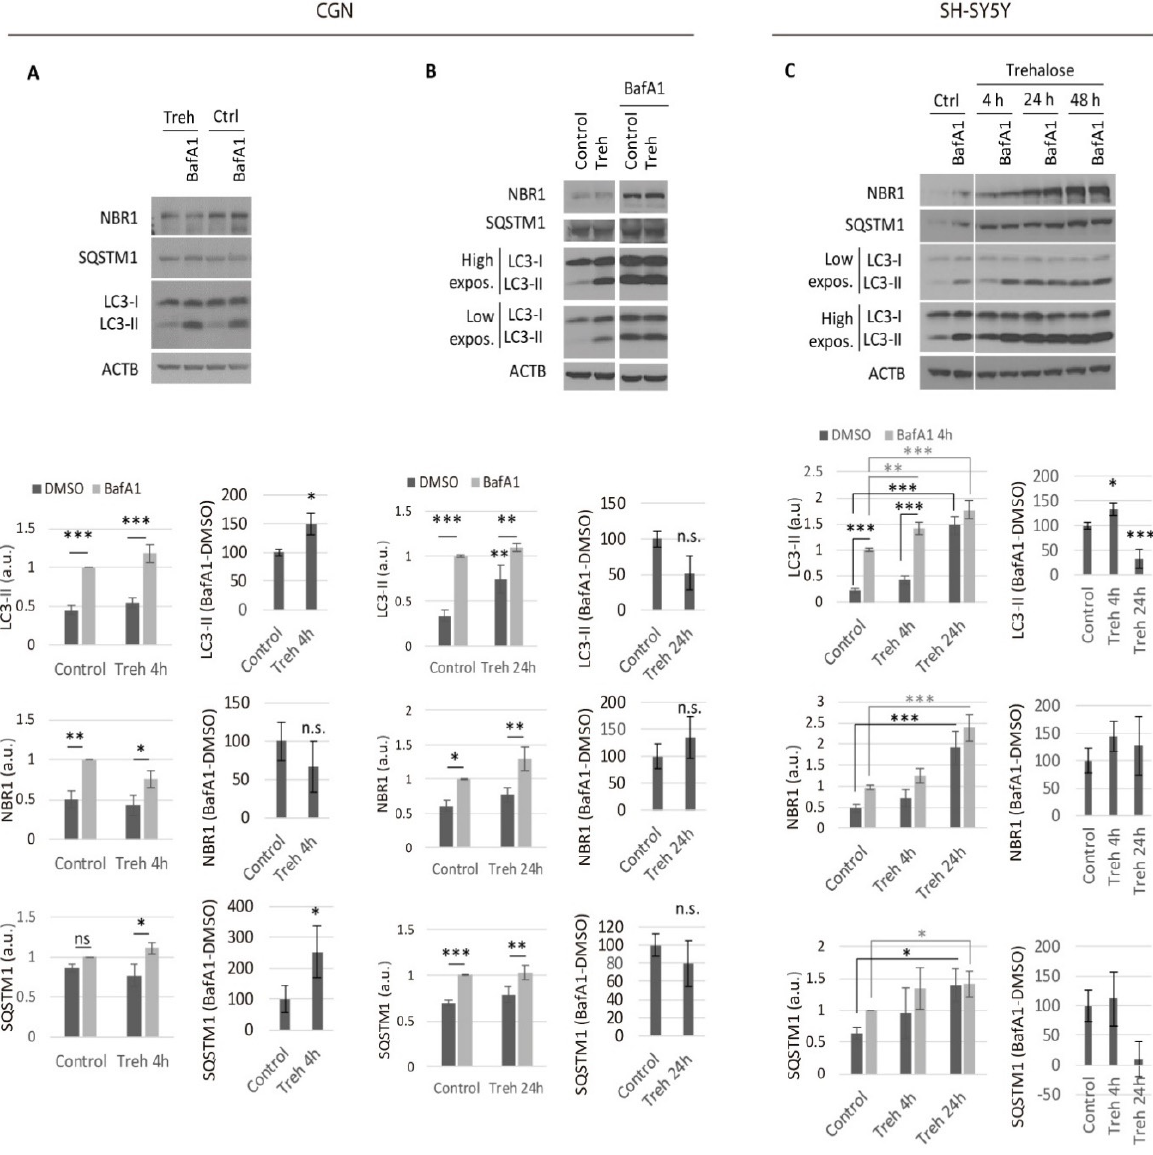
Figure 1. Trehalose only increased the neuronal autophagic flux in the short term. Autophagic flux analysis by addition of 100 nM BafA1(or DMSO as vehicle) during the last 4 h of treatment with 100 mM of Treh for 4 h ( A ) or 24 h ( B ) in CGN cultures; and ( C ) autophagic flux analysis by addition of 100 nM of BafA1 during the last 4 h of treatment with 100 mM of Treh for 4 h, 24 h or 48 h in SH-SY5Y cultures. Two-way ANOVA was performed for NBR1, SQSTM1, and LC3-II levels. The quantitative data, BafA1 versus the control, were normalized and represented as 100 relative units. Student’s t-test was performed for comparisons of NBR1, SQSTM1, and LC3-II levels in the presence-absence of BafA1 (BafA1-DMSO). ( n ≥ 3; * p ≤ 0.05; ** p ≤ 0.01; and *** p ≤ 0.001). Bars represent mean ± SEM. NBR1, SQSTM1, and LC3-II were measured to determine the autophagic status and ACTB as an internal control. n.s.: not